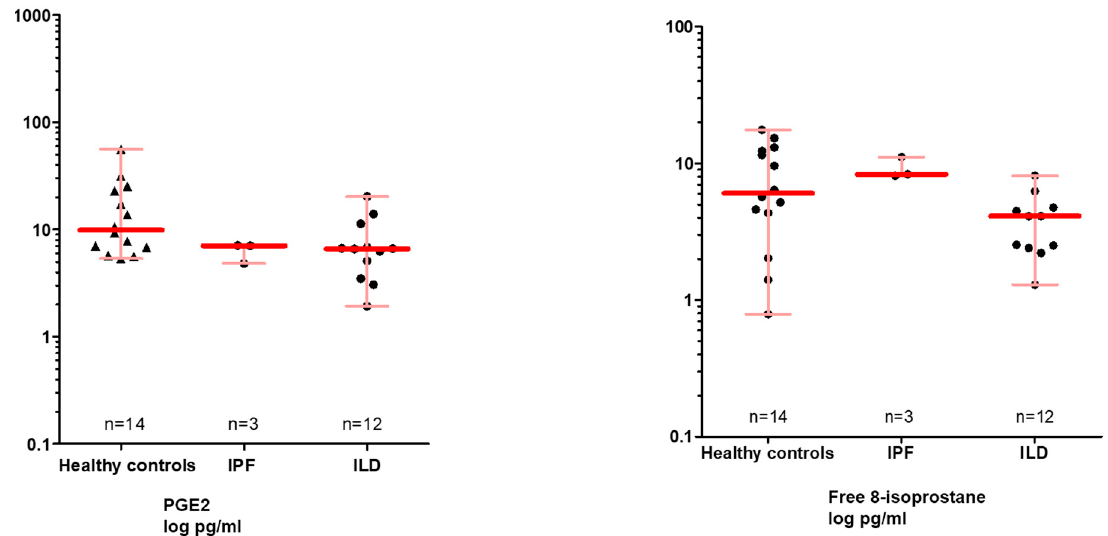
Figure 2. Free 8-isoprostane and PGE 2 in the EBC. Given is the median with interquartile range. HP, uILD, DIP, COP, sarcoidosis as well as CTD-ILD have been summarized as ILDs. Abbreviations: IPF—idiopathic pulmonary fibrosis, ILD—interstitial lung diseases. EBC was analyzed after concentrating its content. If data not available from all patients, the number (s) is specified.